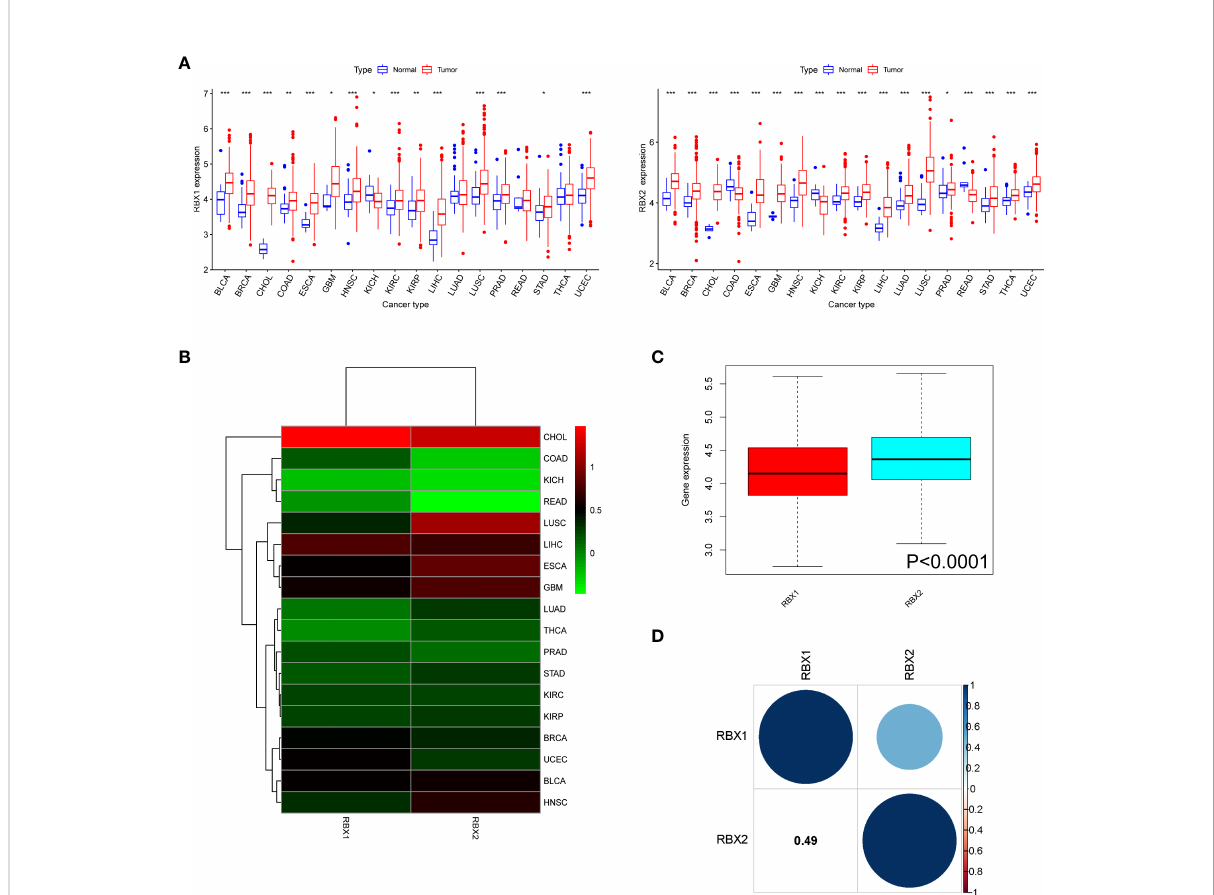
FIGURE 1 The mRNA expression patterns of RBX1/2 in cancers. (A) Comparison of RBX1/2 expression between tumor and normal samples. (B) Heatmap showing the difference of RBX1/2 gene expression in 18 cancer types from TCGA database. The red and green indicate the high or low expression, respectively. (C) Boxplot illustrating the distribution of RBX1/2 gene expression in various cancer. (D) The correlation between RBX1 and RBX2. The blue dot indicated the positive correlation. * P < 0.05, ** P < 0.01, *** P <